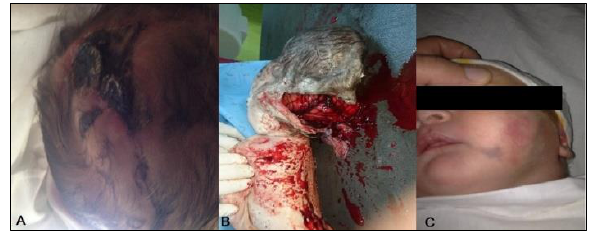
Figure 1: A) Showing ruptured cephalhematoma in the first patient. B) Extensive scalp laceration with visible brain tissue and massive hemorrhage in the second patient. C) Ecchymosis of the cheek in the third patient.